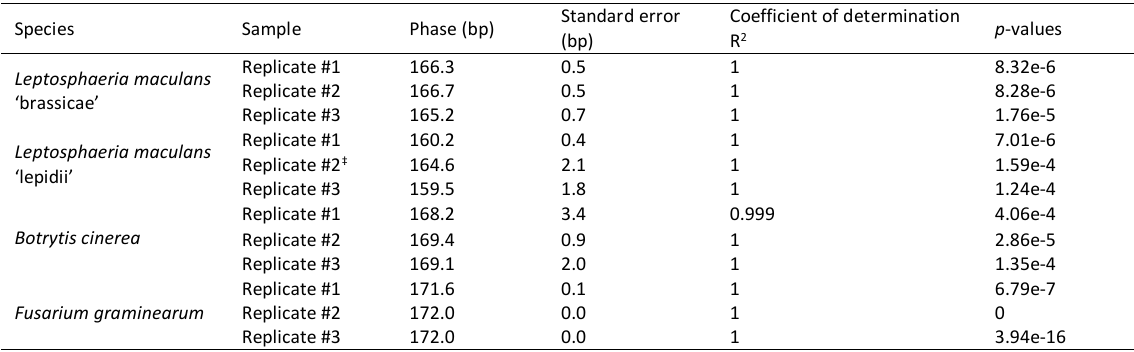
Supplementary Table 2. Summary of phases, standard errors, coefficient of determination R 2 , and p -values ( F -test) determined after linear regression fitting